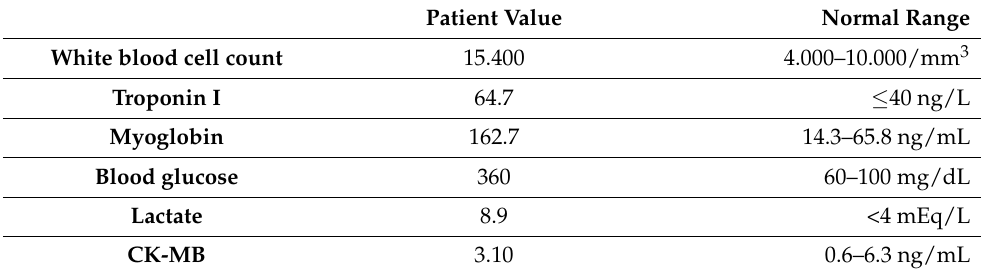
Table 3. Blood chemistry test results when the patient was admitted to Emergency Department. Patient